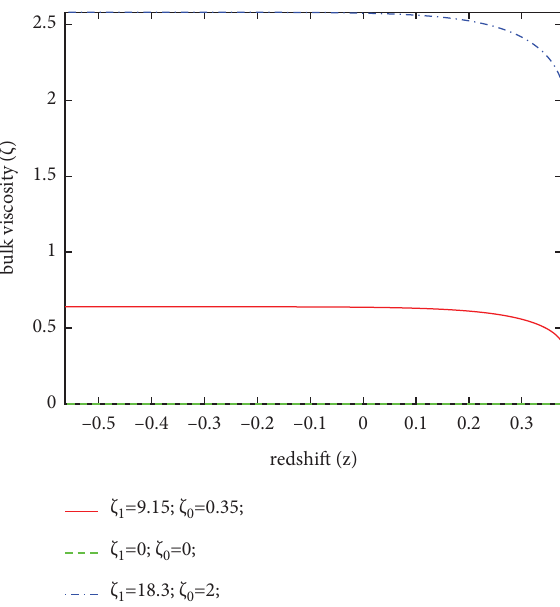
Figure 7: Bulk viscosity ( ζ ) versus redshift ( z ) for BT-II.